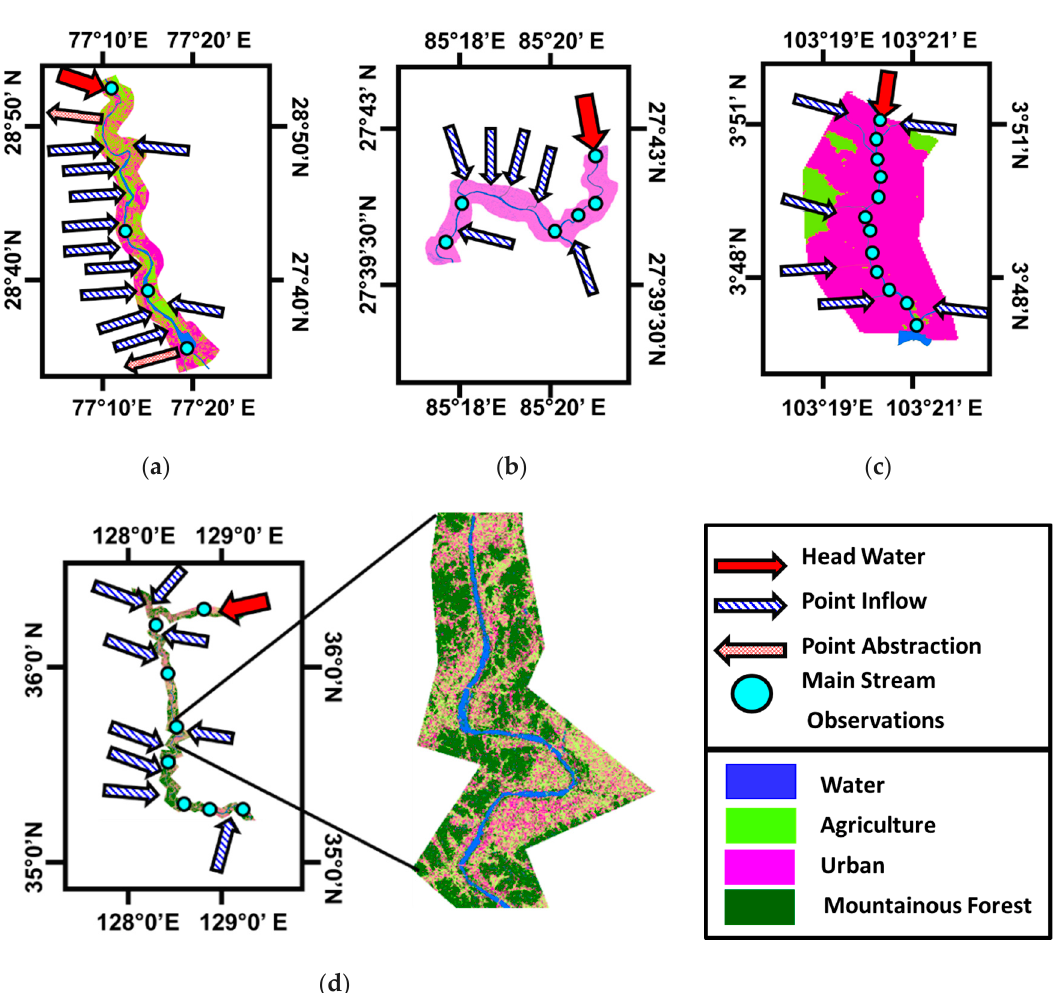
Figure 2. Description of study area ( a ) Yamuna River, India; ( b ) Baghmati River, Nepal; ( c ) Galling River, Malaysia; and ( d ) Nakdong River, Korea.